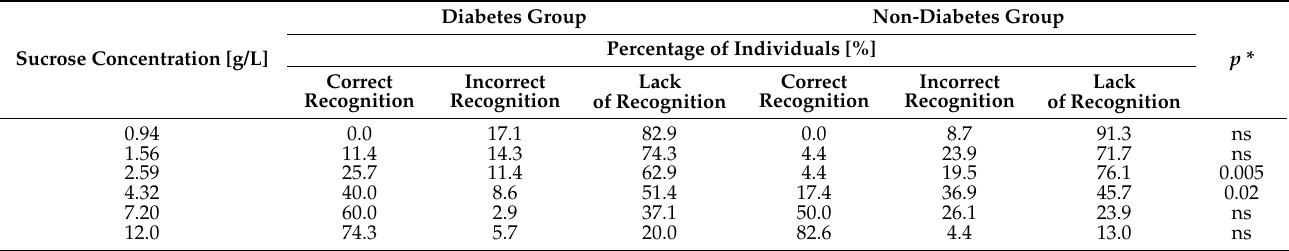
Table 4. Evaluation of the recognition of the taste of sucrose solutions.